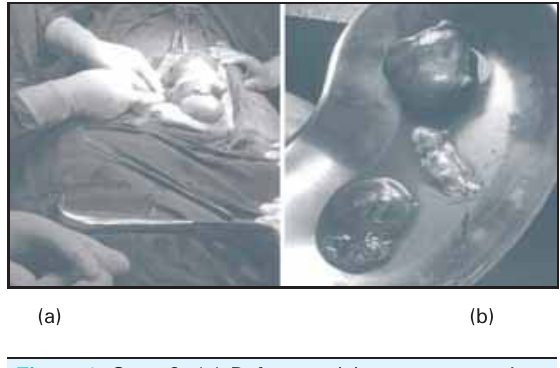
Figure 1. Case 2. (a) Before excision, pregnancy in a non-communicating rudimentary horn; (b) Excised rudimentary horn, with the fallopian tube, fetus and